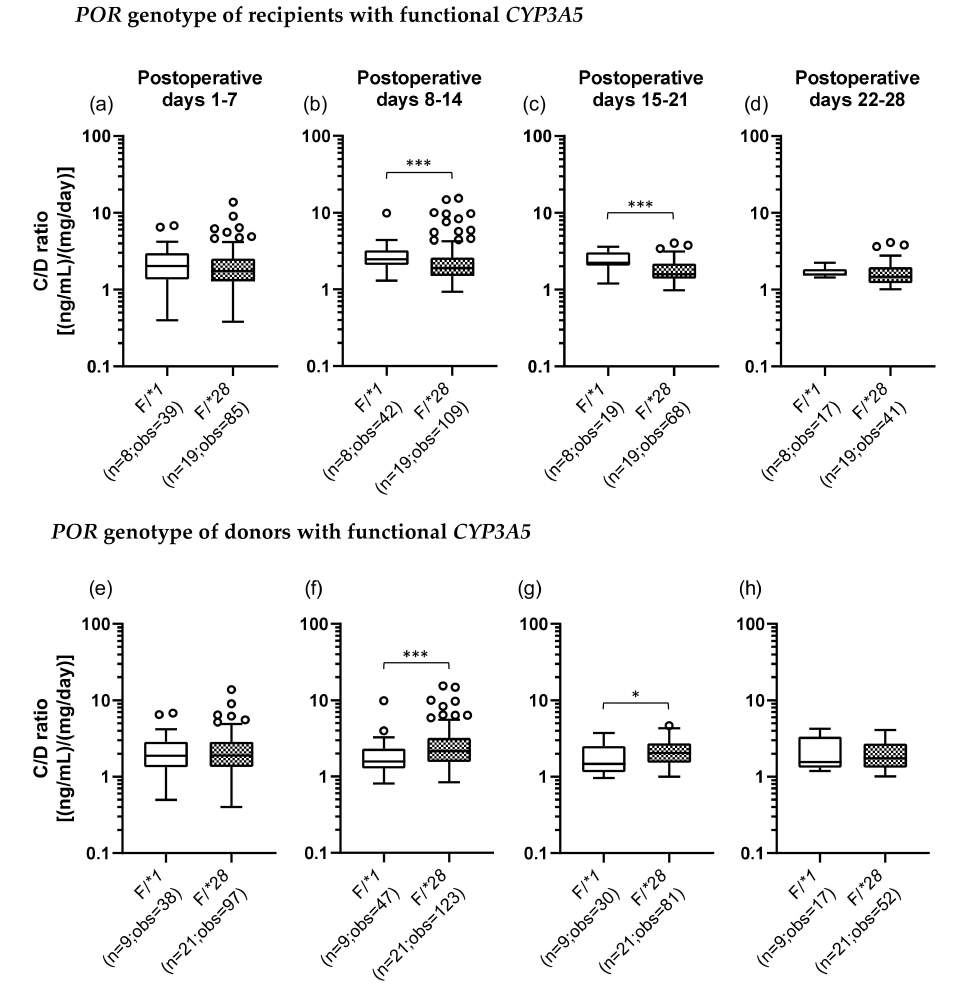
Figure 3. Impact of the POR*28 polymorphism in the recipients ( a – d ) and donors ( e – h ) with functional CYP3A5 ontheC / Dratiooftacrolimusonpostoperativedays1–28afterliving-donorlivertransplantation. The C / D ratios of tacrolimus for days 1–7 (a, e), 8–14 (b, f), 15–21 (c, g), and 22–28 (d, h) after transplantation were compared by the POR polymorphism (F, functional; *1, POR*1 / *1 ; and *28, POR*1 / *28 and POR*28 / *28 ). The bar indicates the median tacrolimus C / D ratio for each group, and boxes represent the 25th and 75th percentiles of the data. The whiskers represent the lowest and highest values that fall within 1.5 times the interquartile range of the lower and upper quartiles, respectively. *p < 0.05 and *** p < 0.001 between groups. n, Number of patients; obs, number of observations i.e., number of tacrolimus